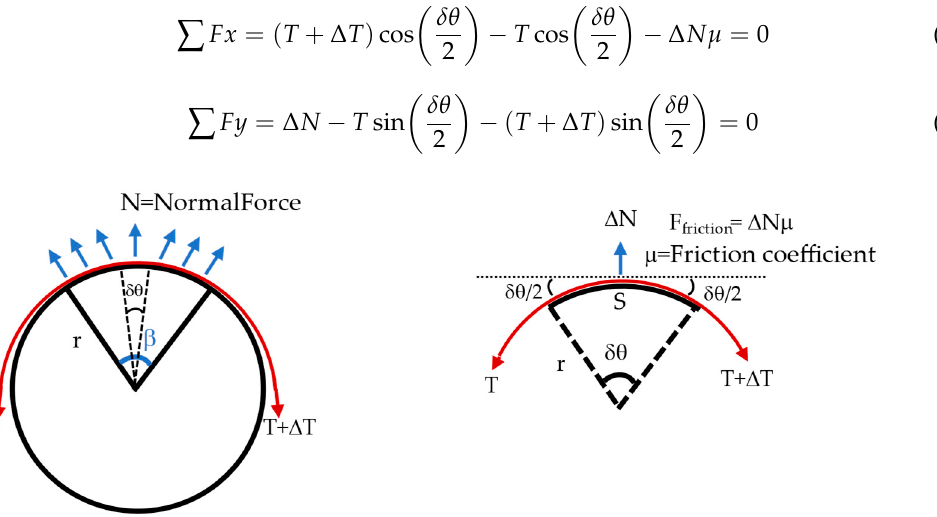
Figure 8. ( a ) Representation of contact reaction forces from single point force sensors and net result- ant force along with ( b ) sensor hysteresis.